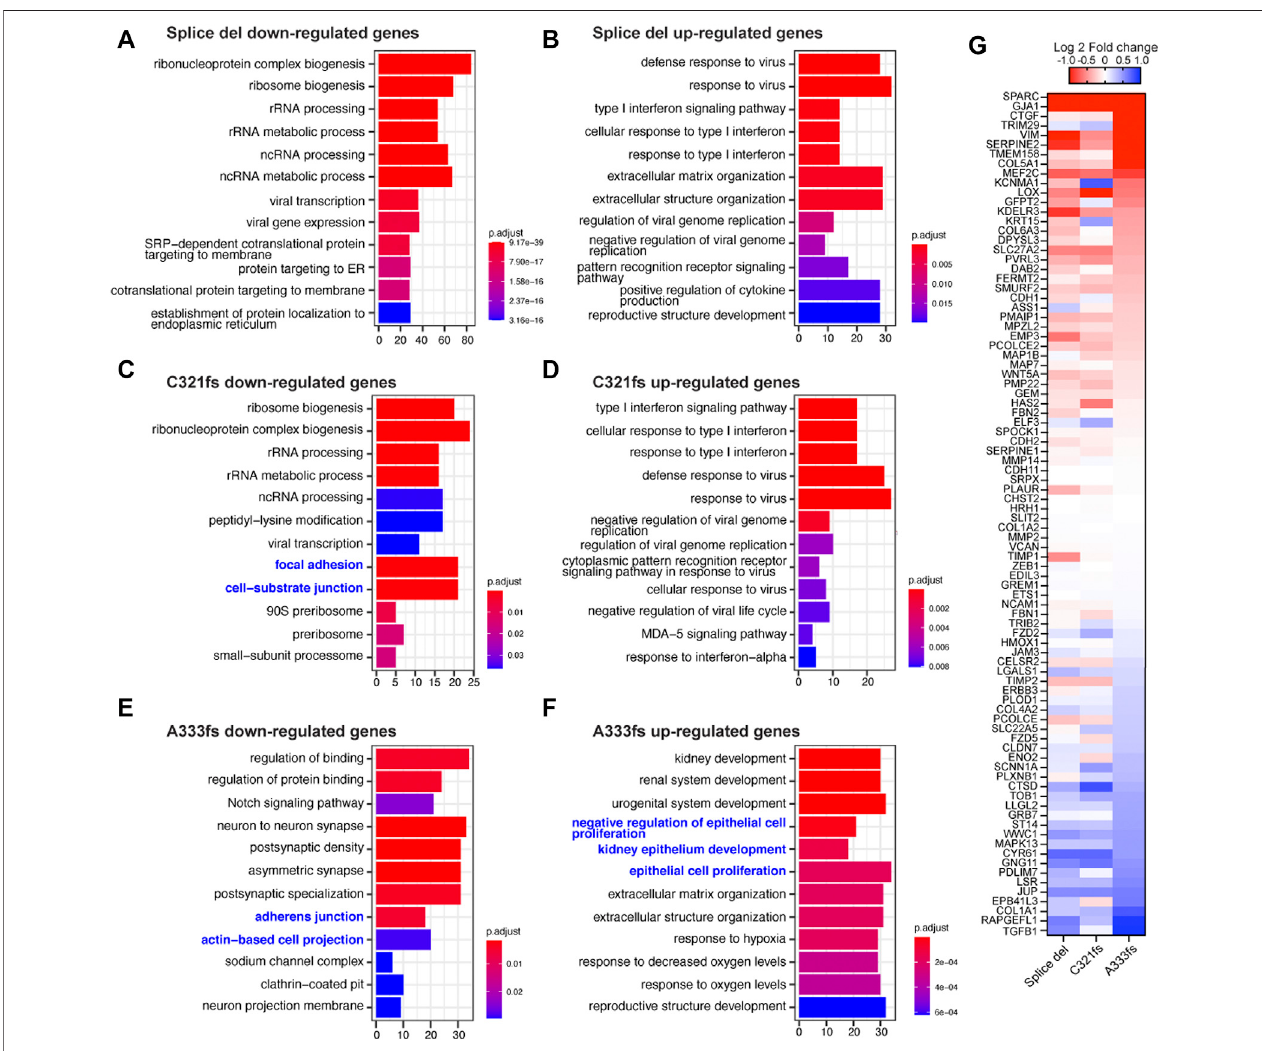
FIGURE3| Biological pathways enriched inGATA3 mutant cells. (A,B) Top 12signi fi cantlyenriched pathways ofdown- (A) or up- (B) regulatedgenesinSplice del mutant T47D cells (C,D) Top 12 signi fi cantly enriched pathways of down- (C) or up- (D) regulated genes in C321fs mutant T47D cells (E,F) Top 12 signi fi cantly enriched pathways of down- (E) or up- (F) regulated genes in A333fs mutant T47D cells. Pathways related to EMT or MET are highlighted in blue. (G) Heatmap showing EMT- relatedgeneexpression inthemutantcells. Relativegeneexpression (Log twoFold change)against controlT47Dcellsisshown.91universalEMTgenes(Parsana et al., 2017) are used for the heatmap